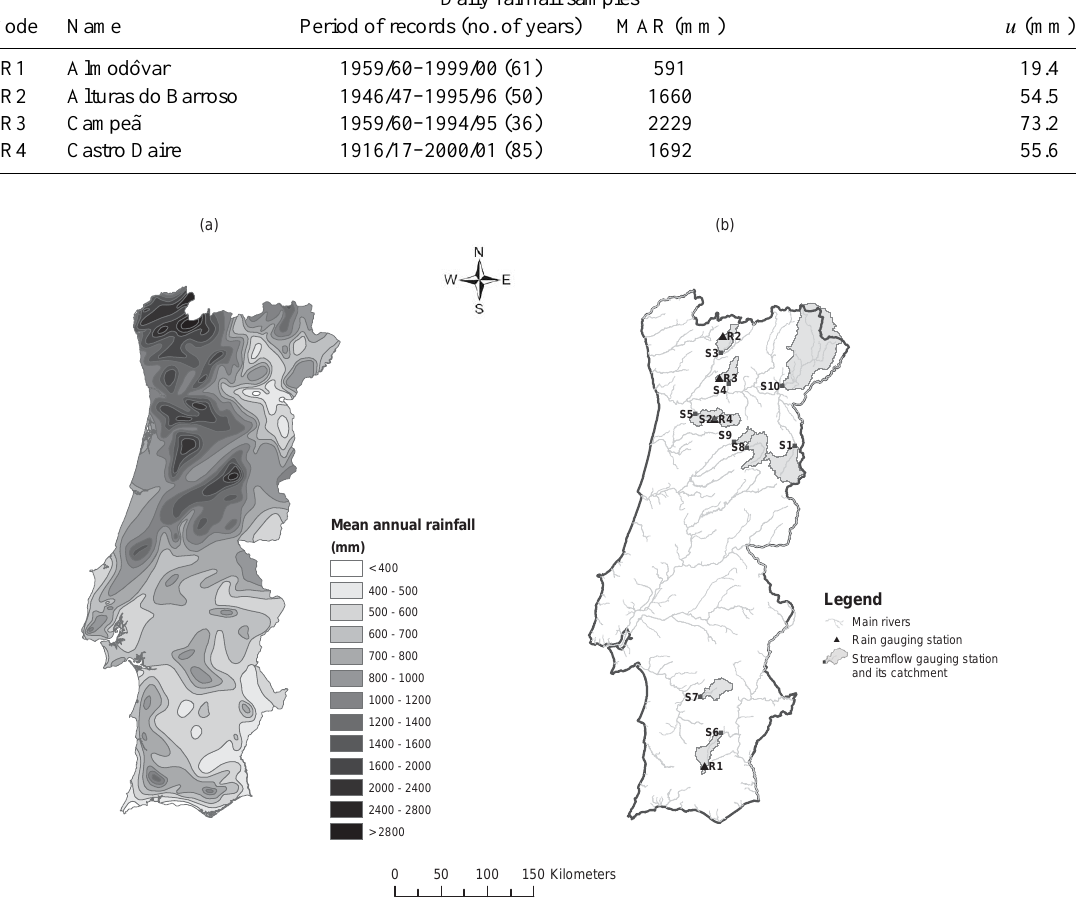
Fig. 1. Mainland Portugal. (a) Countour map of the mean annual rainfall. Source: Portuguese Environmental Agency (APA, http://sniamb.apambiente.pt/webatlas/), based on the climatological normals of reference, corresponding to the period 1931–1960, using Table 1. The shaded areas correspond to the catchments under